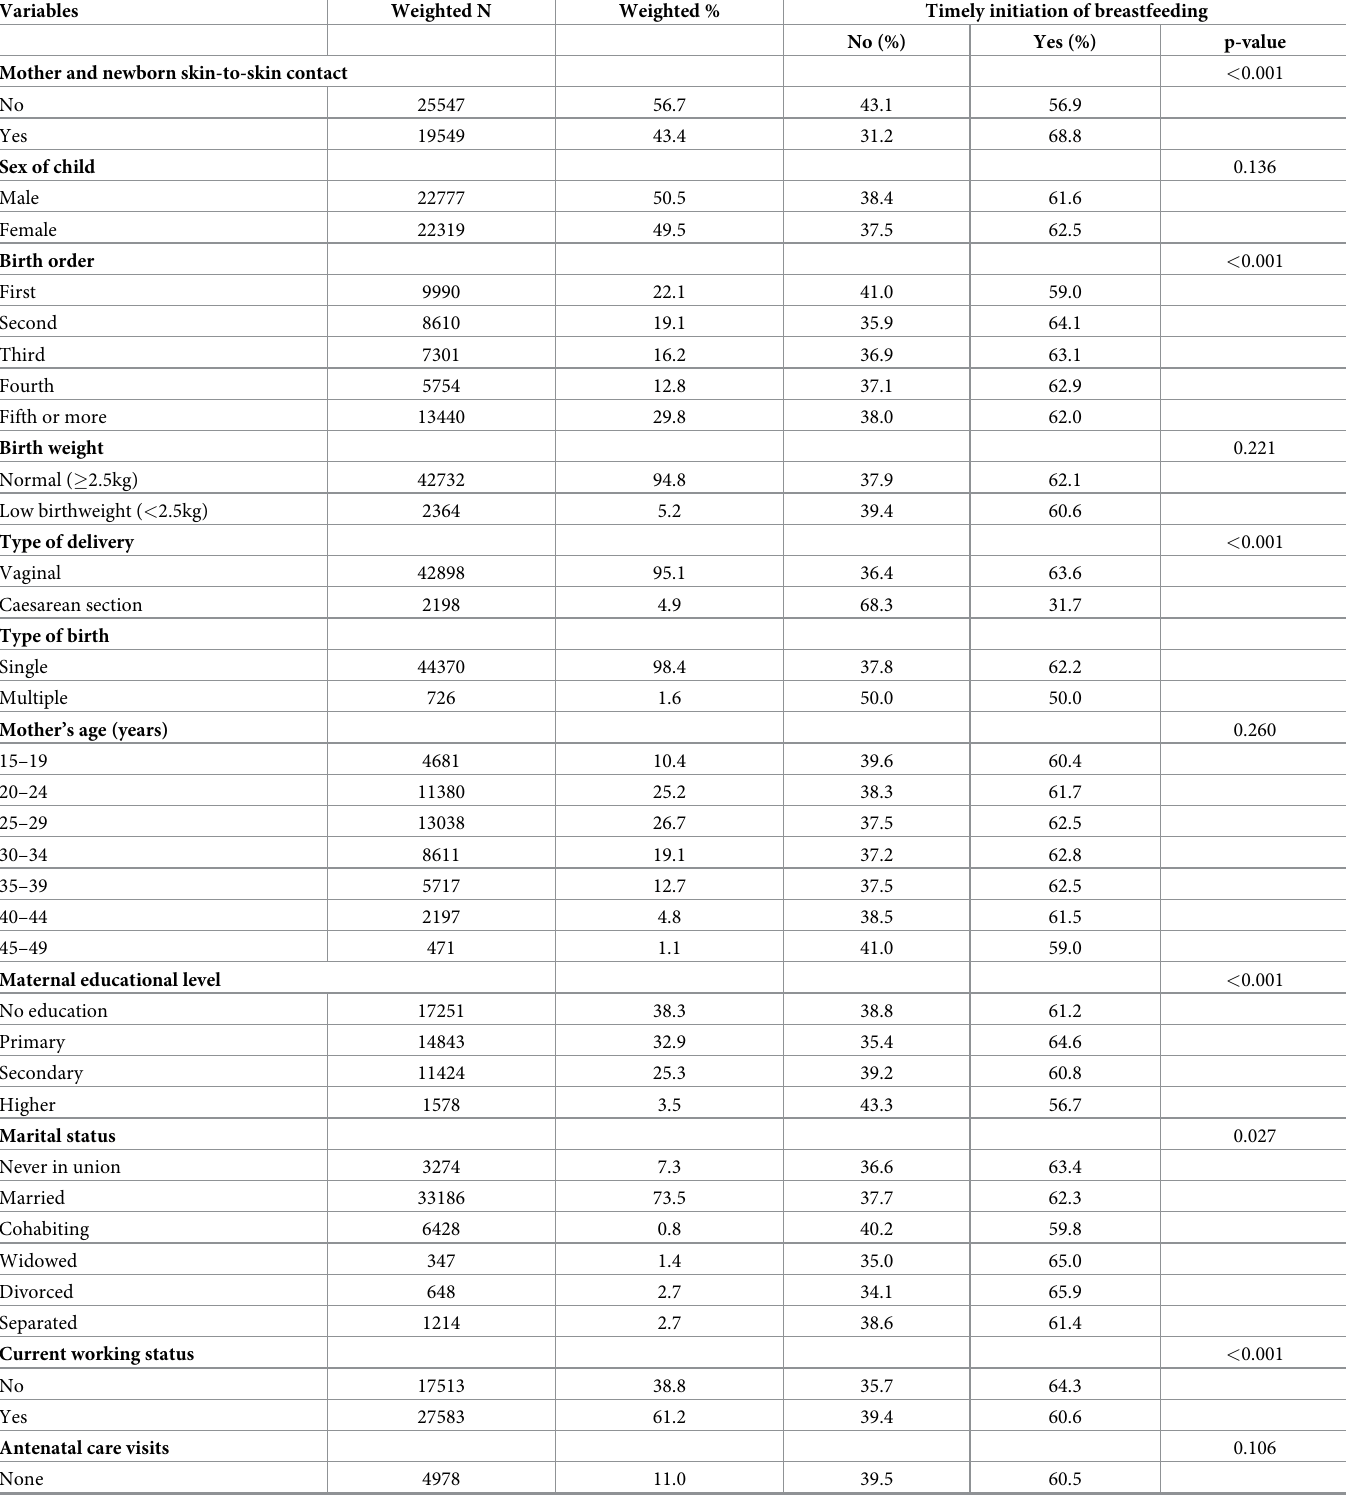
Table 2. Distribution of timely initiation to breastfeeding across the explanatory